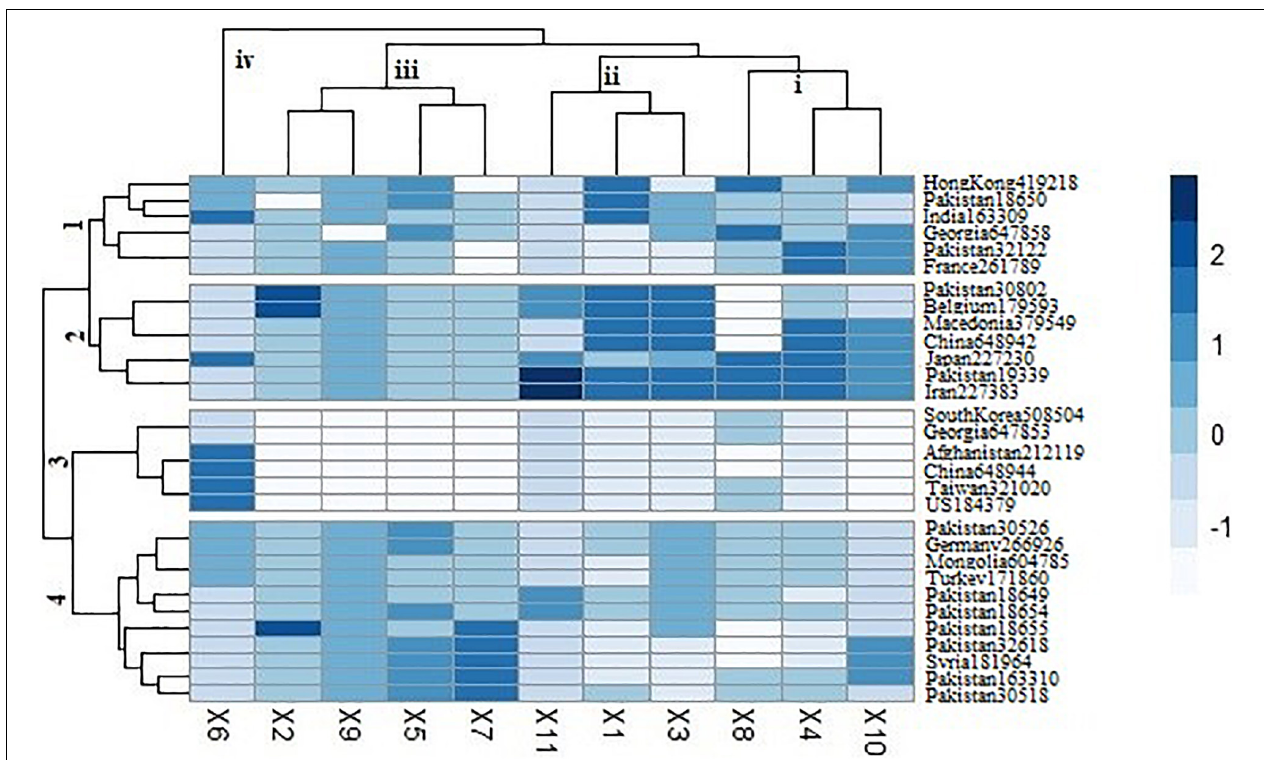
FIGURE 4 | Heat map clustering of spinach accessions based on functionally characterized genes. X1 = Glycolate oxidase, X2 = Oxalyl CoA Synthetase, X3 = Glucose-6-Phosphate Dehydrogenase, X4 = Malate Dehydrogenase, X5 = Ascorbate Peroxidase, X6 = Iso-citrate lyase, X7 = Formate Dehydrogenase, X8 = Oxalate CoA Ligase, X9 = Malate Synthase, X10 = Citrate Synthase, X11 = Ascorbate Oxidase. Dark blue color is the representation of greater heterozygosity